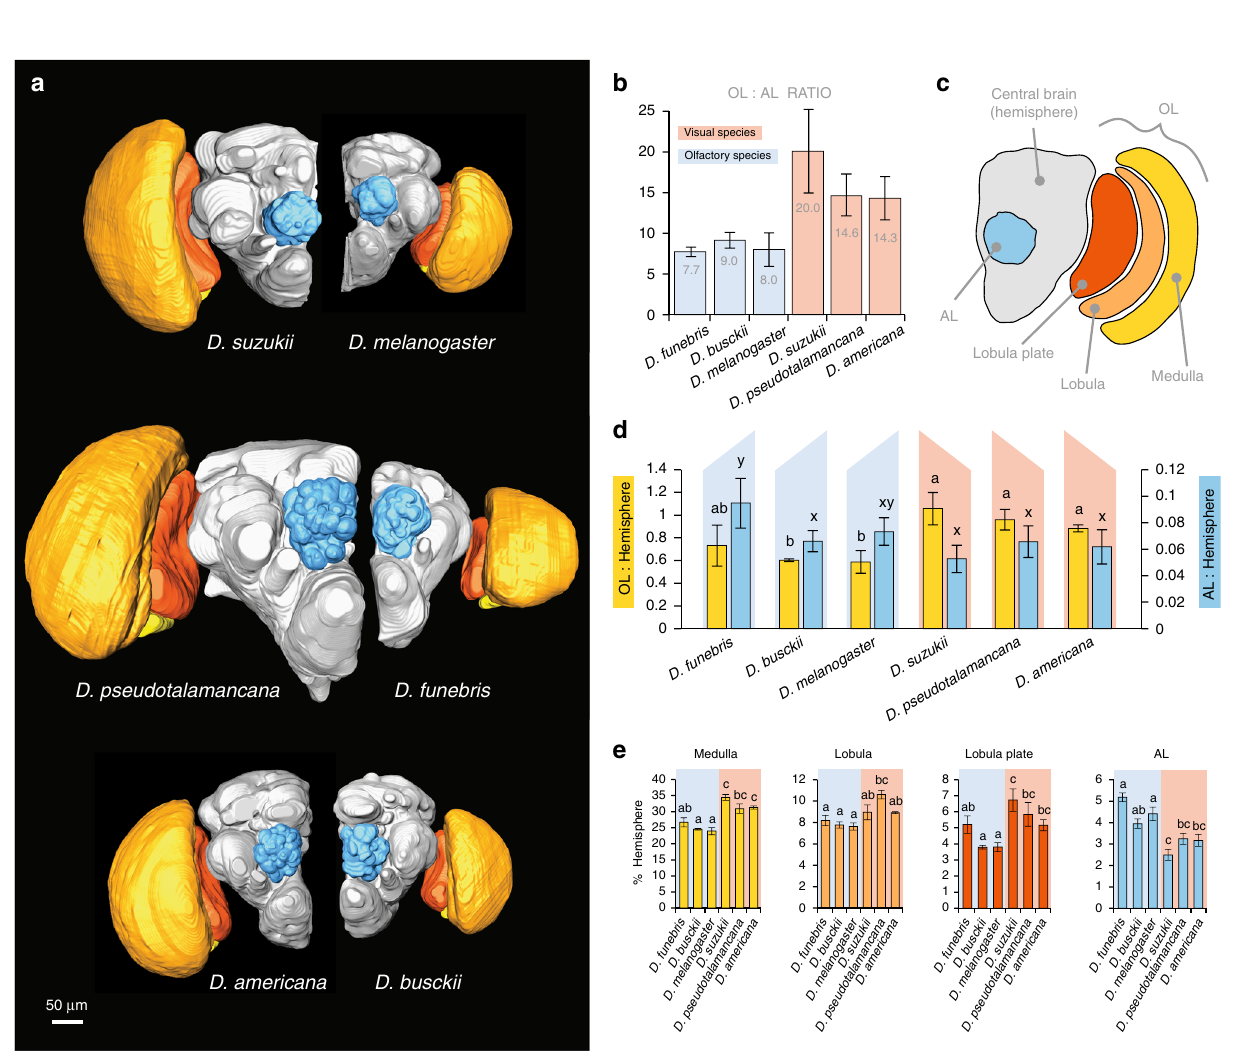
Fig. 2 External comparison of visual and olfactory system. Red color signi fi es vision or predicted visual bias, while blue indicates olfaction or potential olfactory bias. a All 62 species measured for eye and funiculus surface area, where six species were selected for additional measurements. These fl ies were selected to compare species with similar antennal surface area but contrasting eye sizes (e.g., D. pseudotalamancana and D. funebris , or D. americana and D. busckii ) or species with similar eye size but contrasting antennal sizes (e.g., D. americana and D. funebris ). We also selected two well-established species, D. melanogaster and D. suzukii , for an additional comparison and points of reference. b Inverse correlation between ommatidium number and sensillum number when corrected for head size from six species of Drosophila , suggesting a possible tradeoff between these sensory systems at the periphery. c All species were photographed for more detailed measurements of eye and antennal features across several frontal and lateral views. Highlighted in blue are the antennal surface area, and in red, the eye surface area. d Shown are the sensillum density metrics taken from stacked lambda mode scans (maximum intensity projections) of the anterior portion of the antenna for all six species examined, identifying strong differences for example in trichoid sensillum density, where potentially olfactory biased species (in blue) showed the signi fi cantly larger trichoid densities. Error bars represent standard deviation. e Ommatidium counts from each species, which illustrates the large differences in visual capabilities across this genus of fl y, with some species having 2 – 3 times larger eyes. Boxplots represent the median (bold black line), quartiles (boxes), as well as the con fi dence intervals (whiskers). d , e Means with the same letter are not signi fi cantly different from each other (ANOVA with Tukey – Kramer multiple comparison test). f Expanded study to include additional species (that were selected using strati fi ed random sampling), where we show that trichoids are consistently and inversely correlated with increasing eye- to funiculus ratio across the entire genus. (Data are provided at https://doi.org/10.17617/3.1D)